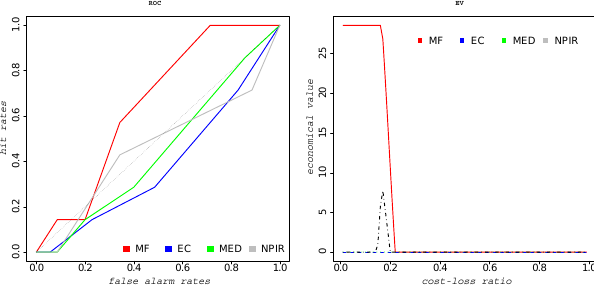
Fig. 10. HPE ROC curves (left; false alarm rates in abscissa, hit rates in ordinate) and Economical Value curves (right; cost-loss ratio in abscissa, economical values in ordinate) for the analogue methodology, from each forecast